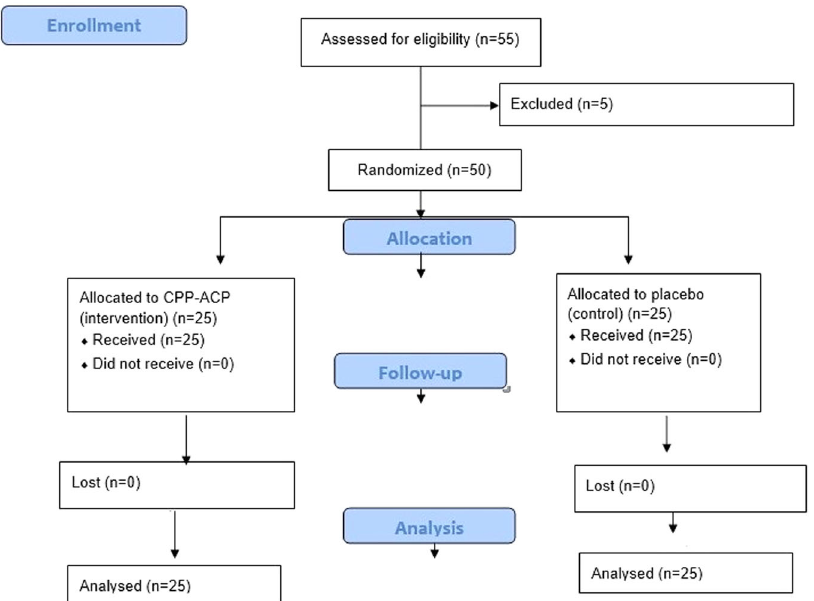
Fig. 1 CONSORT fl ow diagram of participants. Diagram presents particiapnt fl ow through each stage of the study(enrollment, allocation, and